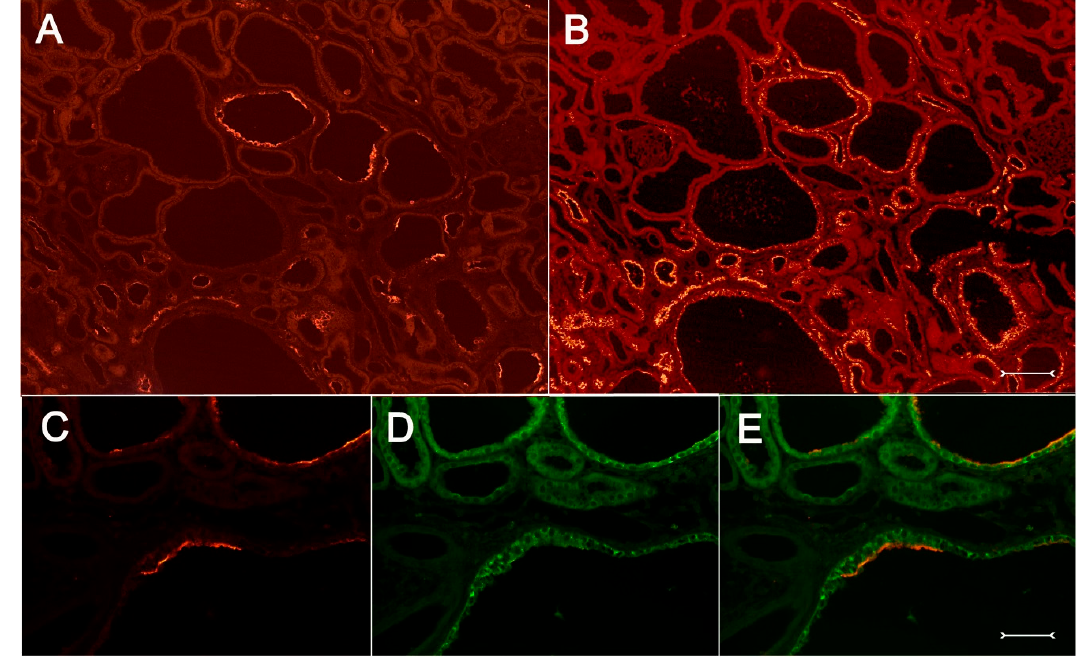
Figure 9. Immunofluorescent expression of Kim-1 and osteopontin in PKD/Mhm (cy/+) rat kidney cortex. In the overview (( A , B ), adjacent sections), Kim-1 ( A ) is only expressed in some cysts, where also osteopontin labeling ( B ) can be detected. Osteopontin staining is found in many more cells and tubular profiles, including distal tubules ( B ). ( C – E ) Double fluorescent labeling with anti-Kim-1 (( C ), red)) and anti-osteopontin antibodies (( D ), green); merged view in ( E ) in cystic profiles. There is coexpression of both proteins in many cyst wall epithelia, while osteopontin expression is noted in some more cystic cells. Bars = 150 µm ( A , B ); 70 µm ( C – F ).